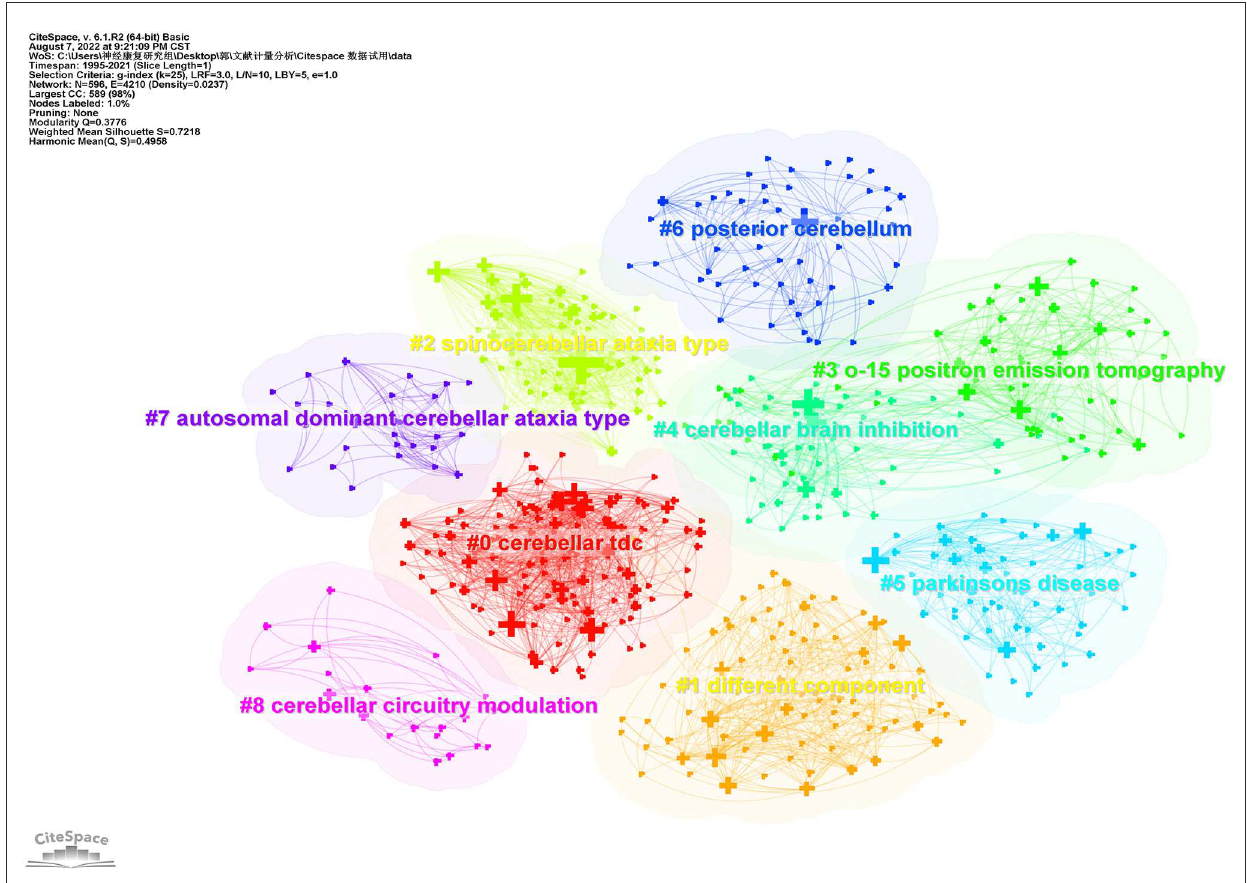
FIGURE10 The keyword co-occurrence cluster map to NICS